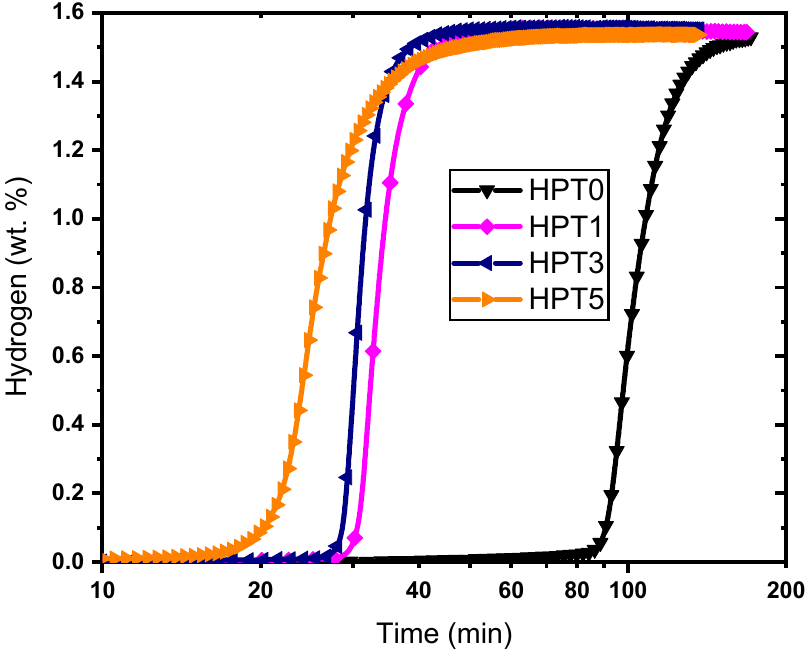
Figure 4. First hydrogenation at room temperature under 1500 kPa of hydrogen of samples after various HPT turns.